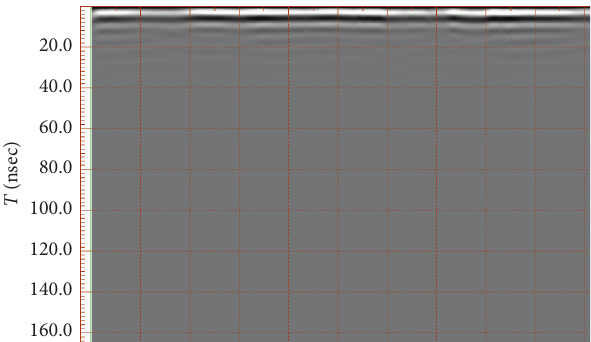
Figure 10: Radar image after the correction of the starting